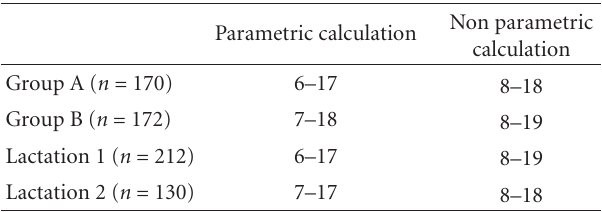
Table 4: Calculated reference ranges for copper ( μ mol/L) in dependence on the di ff erent feeding groups (A and B) and lactations (1 and